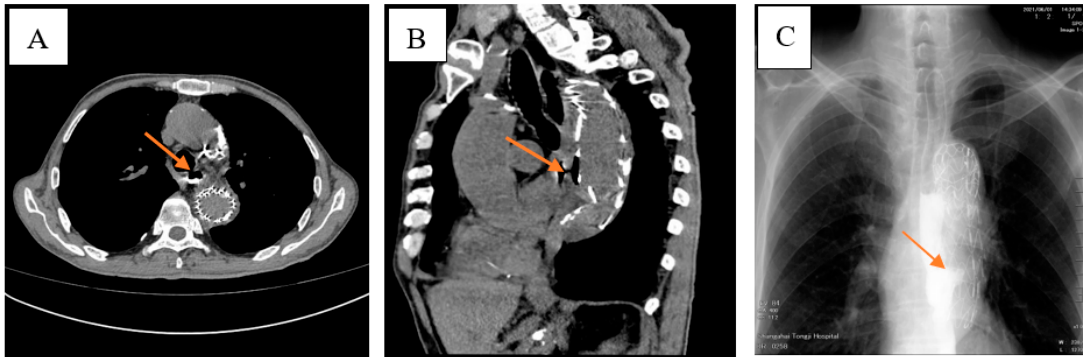
Figure 1. The chest CTA (computed tomography angiography) examination in the outside hospital revealed an esophageal mediastinal fistula and the patient was transferred to our hospital for treatment. Examination before admission of the patient revealed an oesophagus fistula. After the patient was transferred to our department, the CT examination of the chest was perfected to indicate an esophageal mediastinal fistula ( A , B ). An oesophagus lipiodol angiography was performed, and it was seen that the left edge of the middle oesophagus was approximately equal to the 8th thoracic saccular projection and diffused to the left posterior edge ( C ). It was considered that the oesophagus fistula may be large.